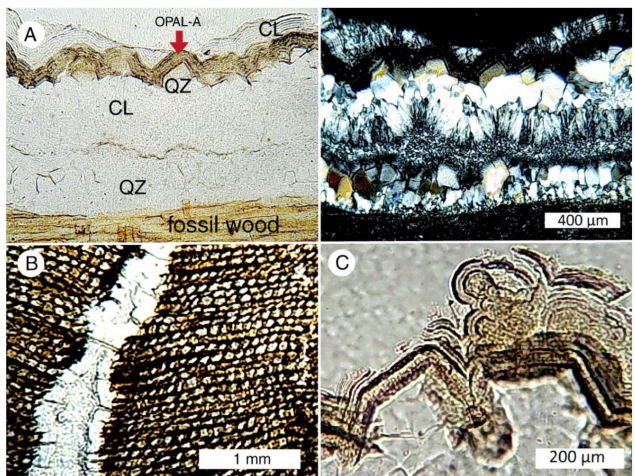
Figure 43. Fracture in Miocene opalized wood specimen from central Washington, USA shows layering of silica minerals deposited by successive episodes of groundwater flow. ( A ) Ordinary transmitted light image on left, polarized light view on right. Crystalline quartz (QZ) was deposited on fossil wood adjacent to the fracture. Chalcedony (CL) was deposited, followed by a second layer of quartz crystals. Terminations of these quartz crystals are coated by thin laminations of opal-A, which are covered by laminar chalcedony. ( B ) Low magnification transverse view of vein crosscutting the cell layers ( C ) Detailed view shows that opal-A layers precipitated on quartz crystal terminations have both laminar and botryoidal morphology. The precipitation of opal over quartz is not a universal phenomenon; in samples from some other localities, quartz crystals developed on an opal substrate, evidence that there is not a single geochemical pathway for